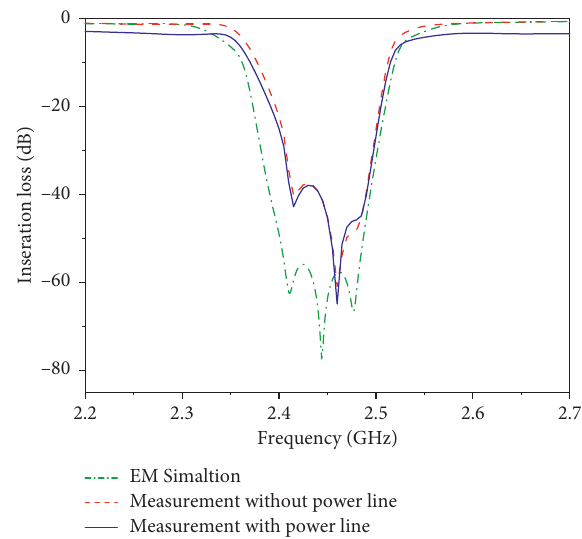
Figure 13: EM simulation and measurement results of the